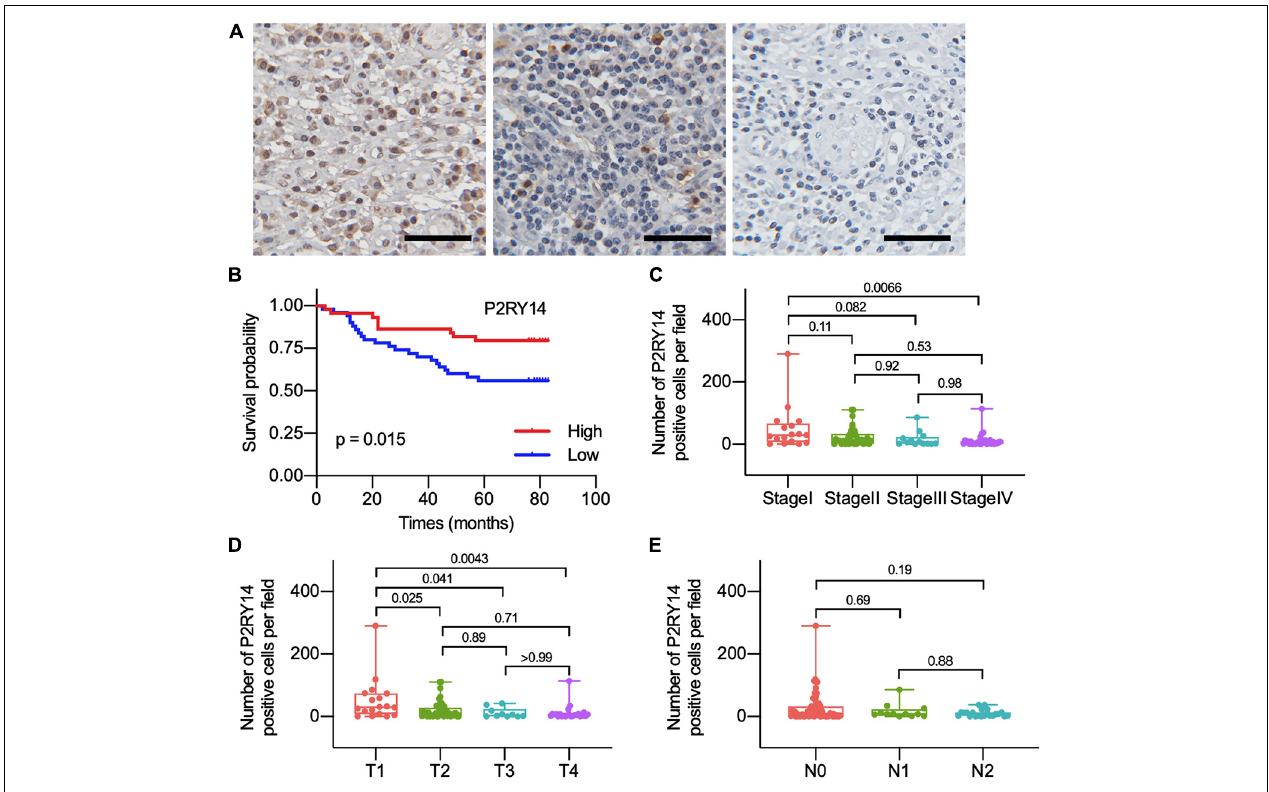
FIGURE 5 | The differentiated expression of P2RY14 in samples and correlation with survival and distribution of OSCC patients. (A) Representative immunohistochemical staining images of P2RY14 in tumor stroma from HNSC patients (scale bar: 50 µ m). (B) Survival analysis for HNSC patients with different P2RY14 expression. (C–E) Distribution of P2RY14 expression level in clinical stage, T classification, and N